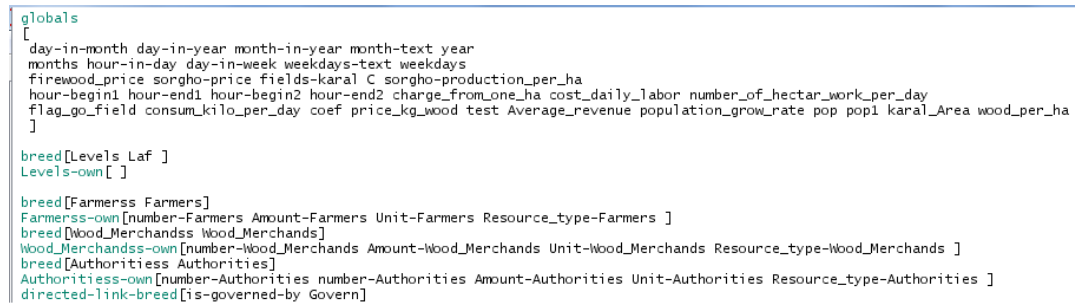
Figure 12. Laf Forest Reserve Process generating NetLogo code for parameter declarations